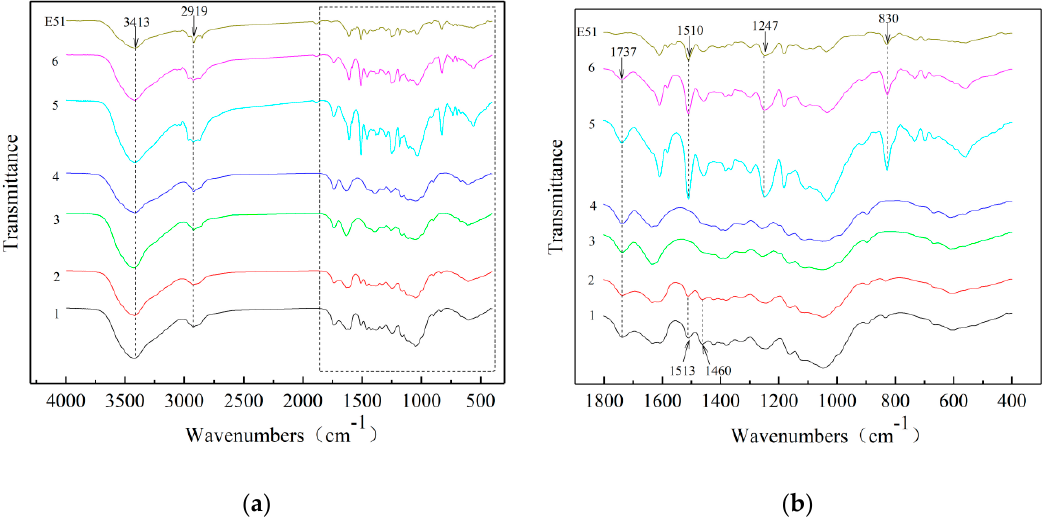
Figure 2. Fourier transform infrared (FTIR) curves of inner bamboo (IB) and heat-treated inner bamboo (HIB) before and after delignification and vacuum impregnation (( b ) is an enlarged view of the dotted box part of ( a ). (1) IB; (2) HIB; (3) DIB; (4) DHIB; (5) TIB; (6) THIB.